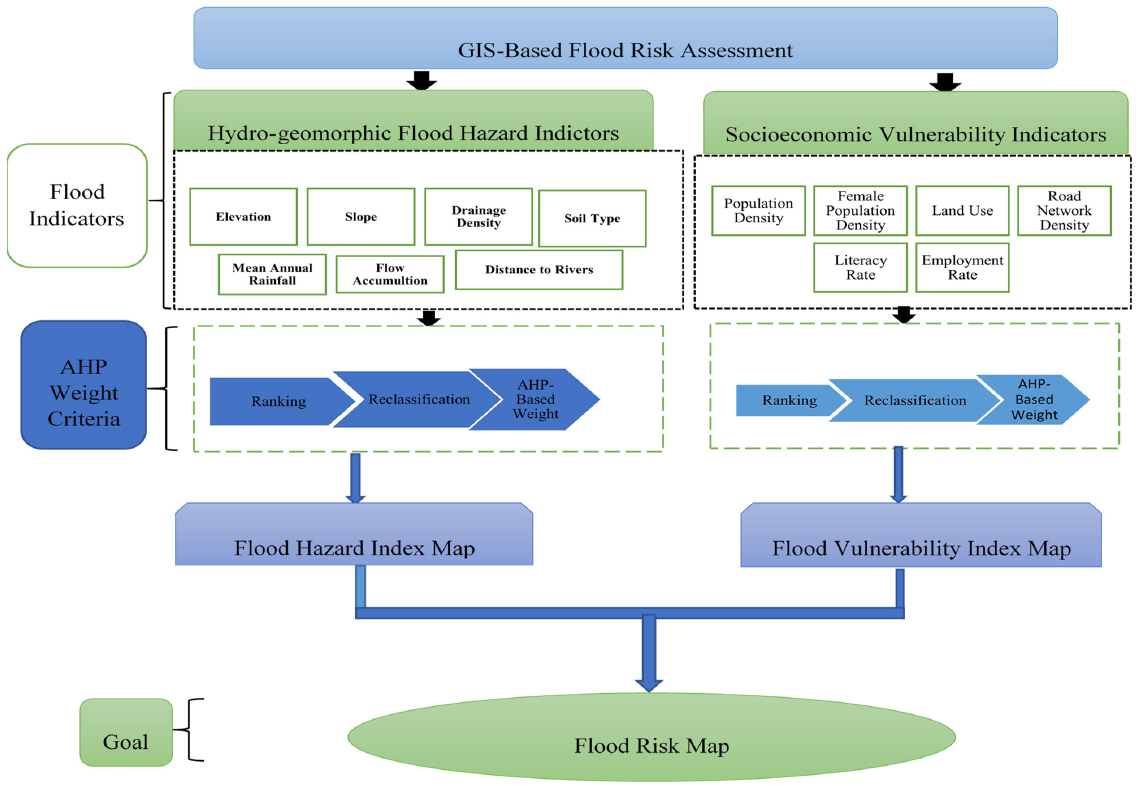
Figure 2. Methodological flow chart of the study.